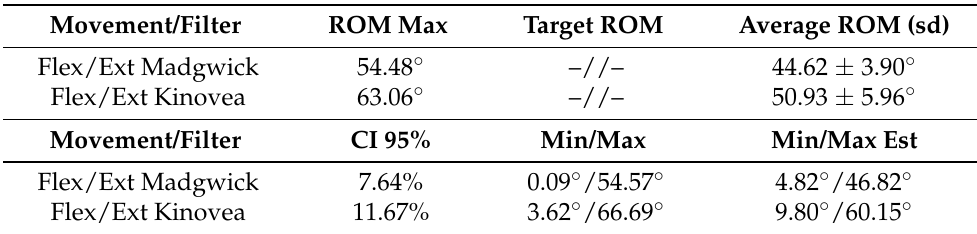
Table 3. Experiment 2—Metrics.